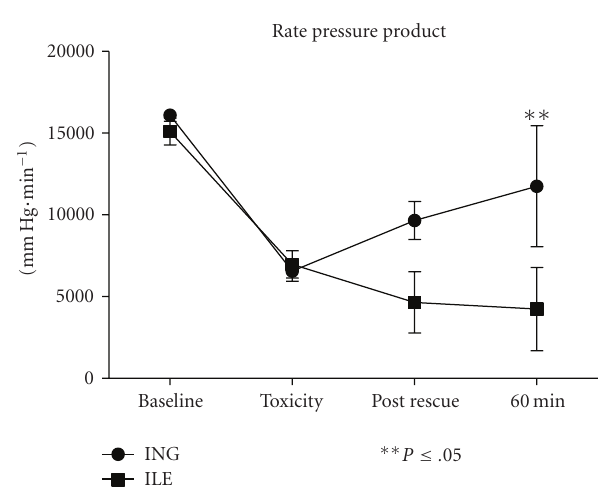
Figure 1: Rate pressure product (RPP) versus